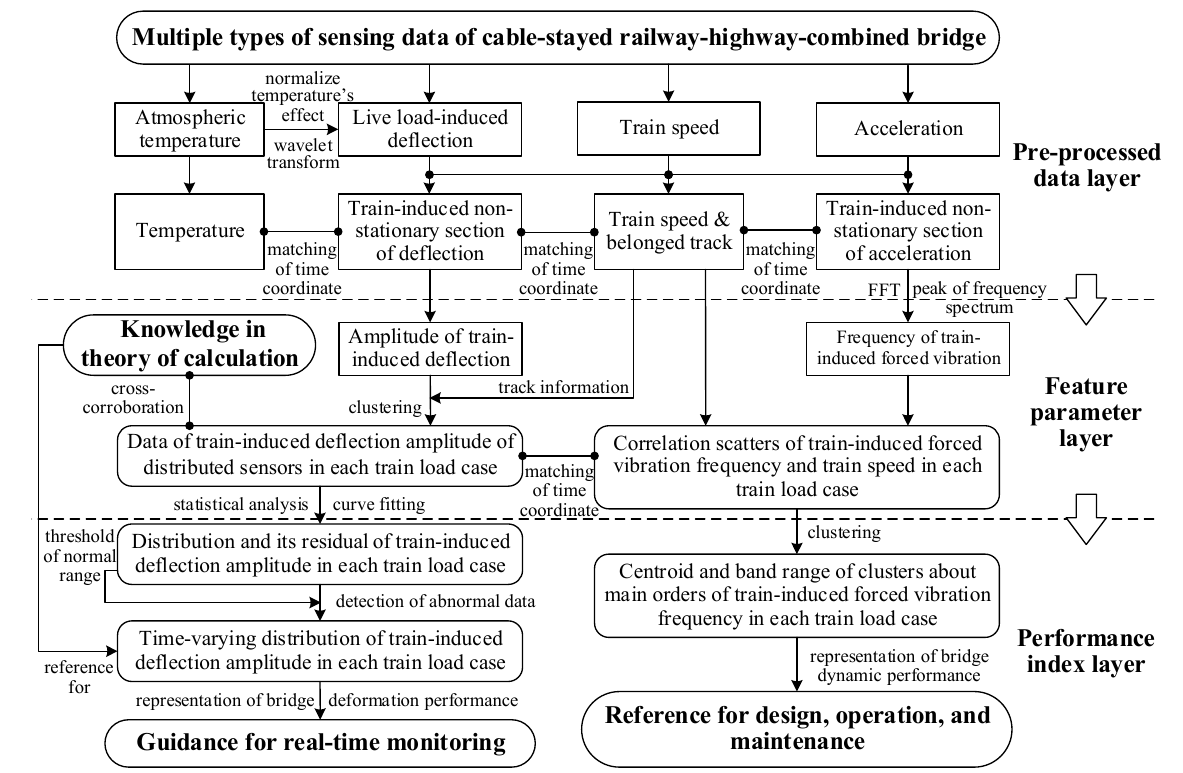
Figure 9. Framework of representation of in-service performance for cable-stayed railway-highway- combined bridge.